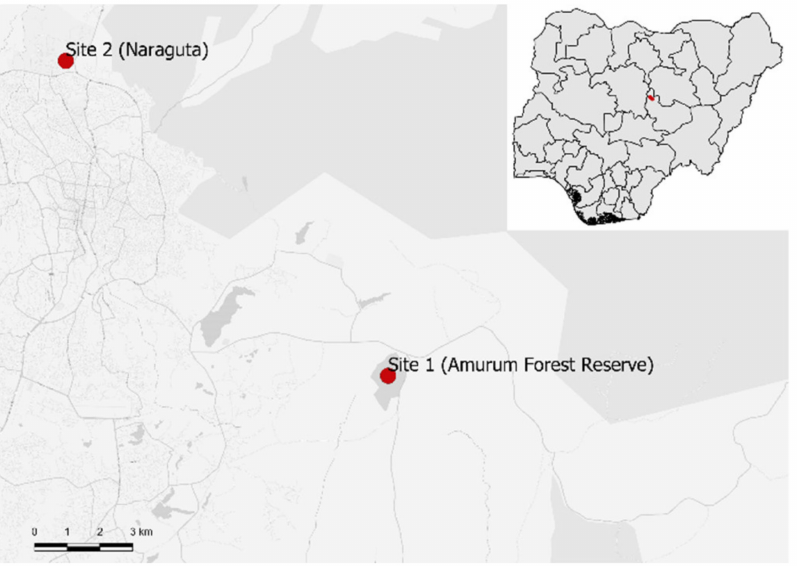
Figure 1. Locations of the study sites within Nigeria (top right insert): Site 1 = Amurum Forest Reserve, Site 2 =